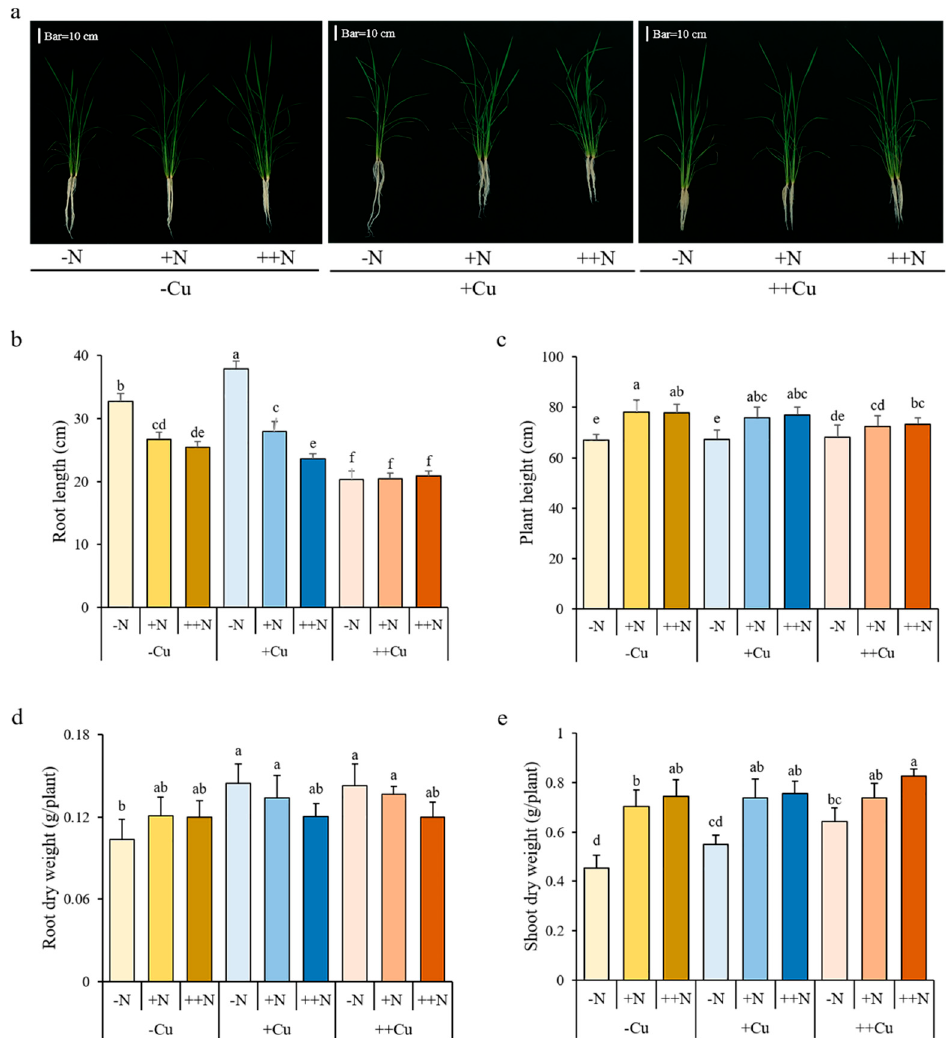
Figure 1. Growth phenotype ( a ), root length ( b ), plant height ( c ), and root ( d ) and shoot ( e ) dry weight of rice plant grown in solutions with different combinations of Cu (-Cu, 0 μ M; +Cu, 0.15 μ M; ++Cu, 1.5 μ M) and N (-N, 0.288 mM; +N, 2.88 mM; ++N, 14.4 mM) supply for three weeks. Data are means ±SD of three biological replicates. Different letters indicate significant difference at p < 0.05 by Tukey’s test.